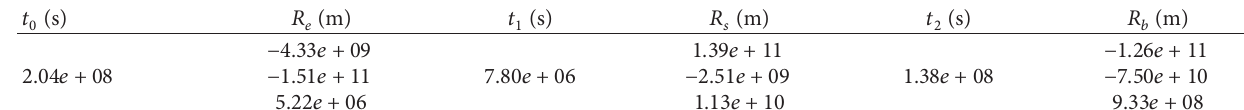
Table 3: 𝑡 0 , 𝑡 1 , 𝑡 2 and corresponding vectors 𝑅 𝑒 , 𝑅 𝑠 , and 𝑅 𝑏 .